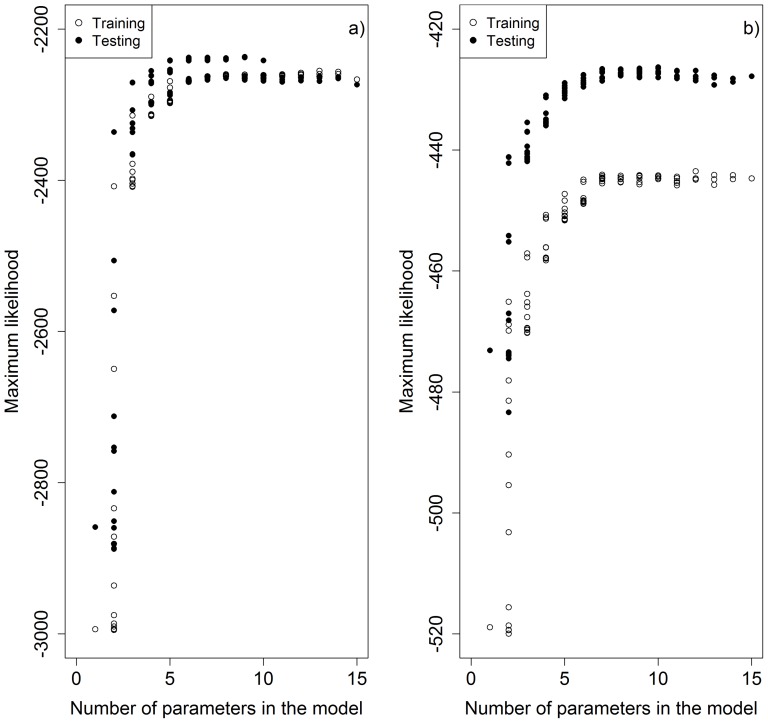
Stepwise regression output.Figure shows both training and testing maximum likelihoods achieved by each of the 106 models used to explain deforestation rates in the Brazilian Amazon in the (a) pre-PPCDAM and (b) post-PPCDAM scenarios.